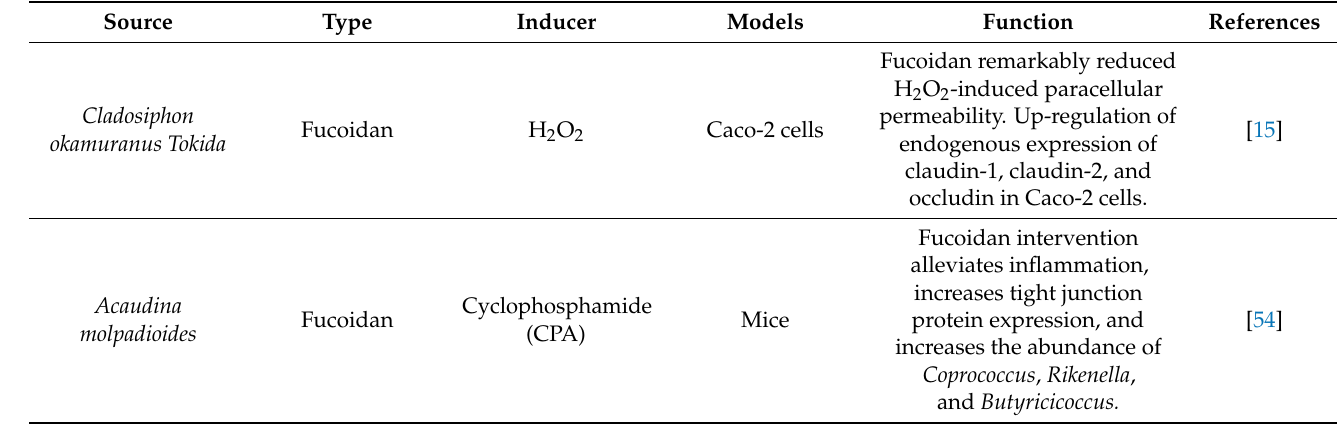
Table 2. Protective effect and mechanism of brown algae-derived polysaccharides on intestinal health.